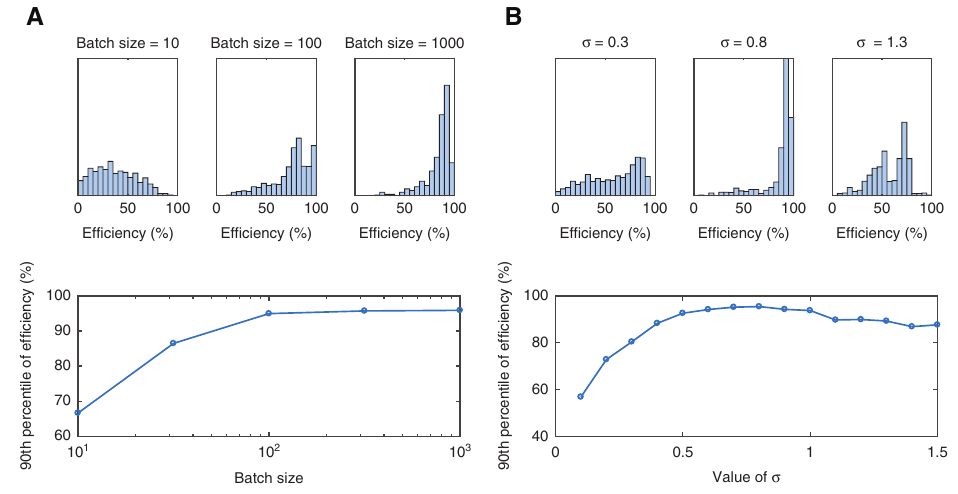
Figure 7: Performance of the unconditional GLOnet for different values of (A) batch size and (B) σ